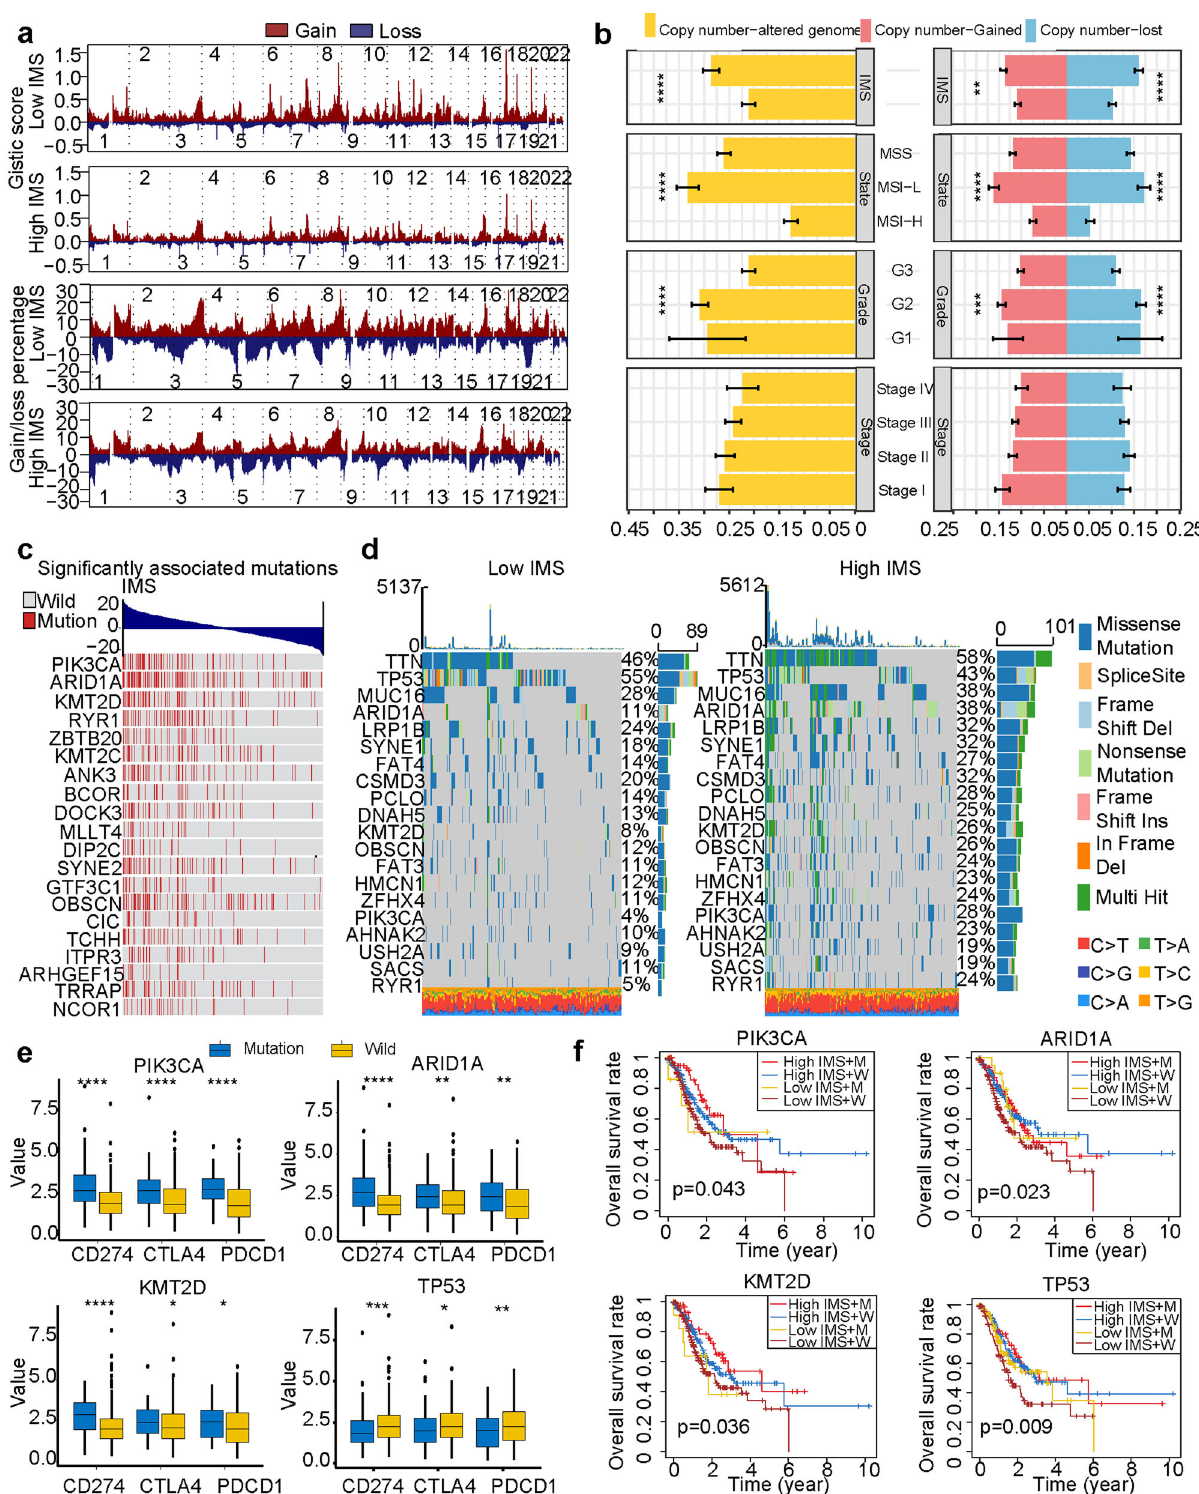
patient ’ s recurrence and prolonged the survival time compared with high IMS without chemotherapy. The results indicate that patients with lower IMS can bene fi t more from chemotherapy after surgery, and it is recommended that patients with lower IMS undergo adjuvant chemotherapy after surgery. Later, we further analyzed the in fl uence of postoperative radiotherapy on